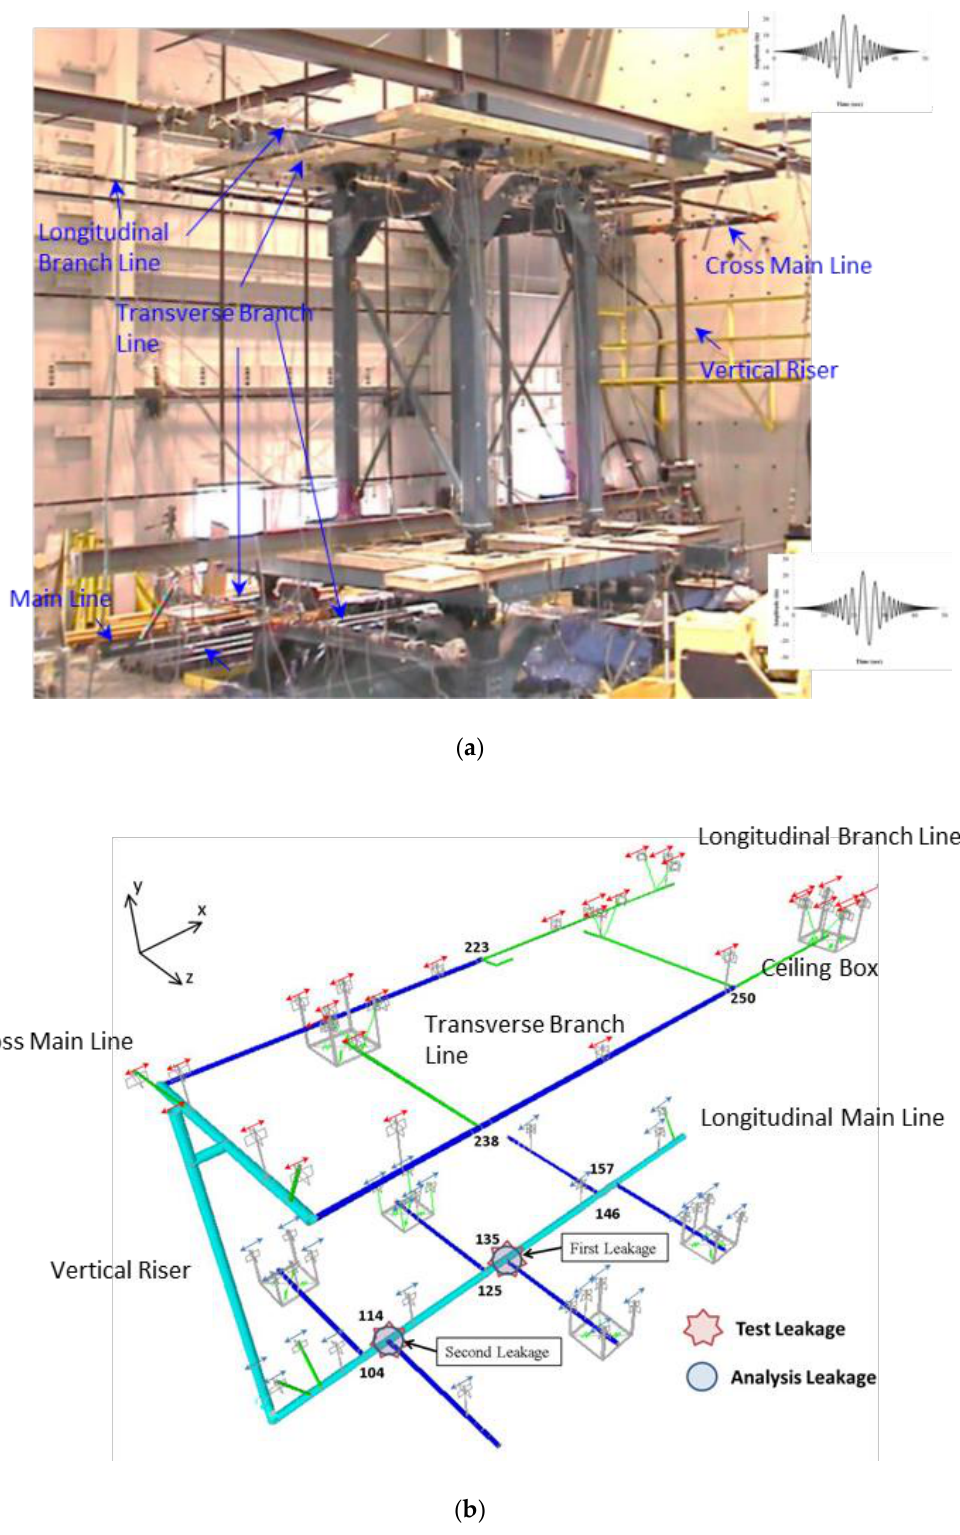
Figure 6. Numerical model validation of two-story piping system: ( a ) dynamic test for two-story sprinkler piping system; ( b ) piping system numerical model verification result.